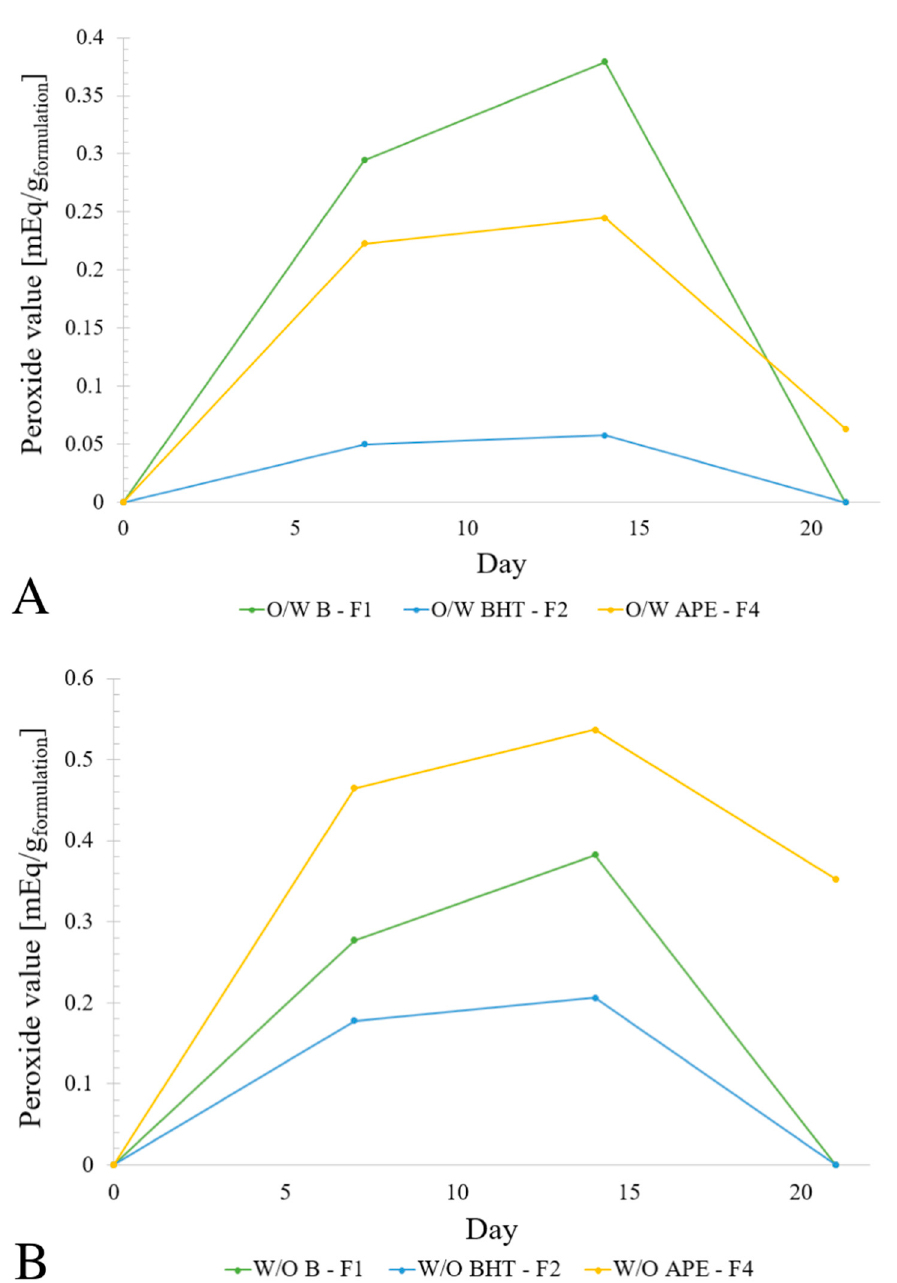
Figure 5. Peroxide values of the O/W and W/O formulations F1, F2 and F4 after the 7th, 14th and 21st day ( A , B ), respectively.